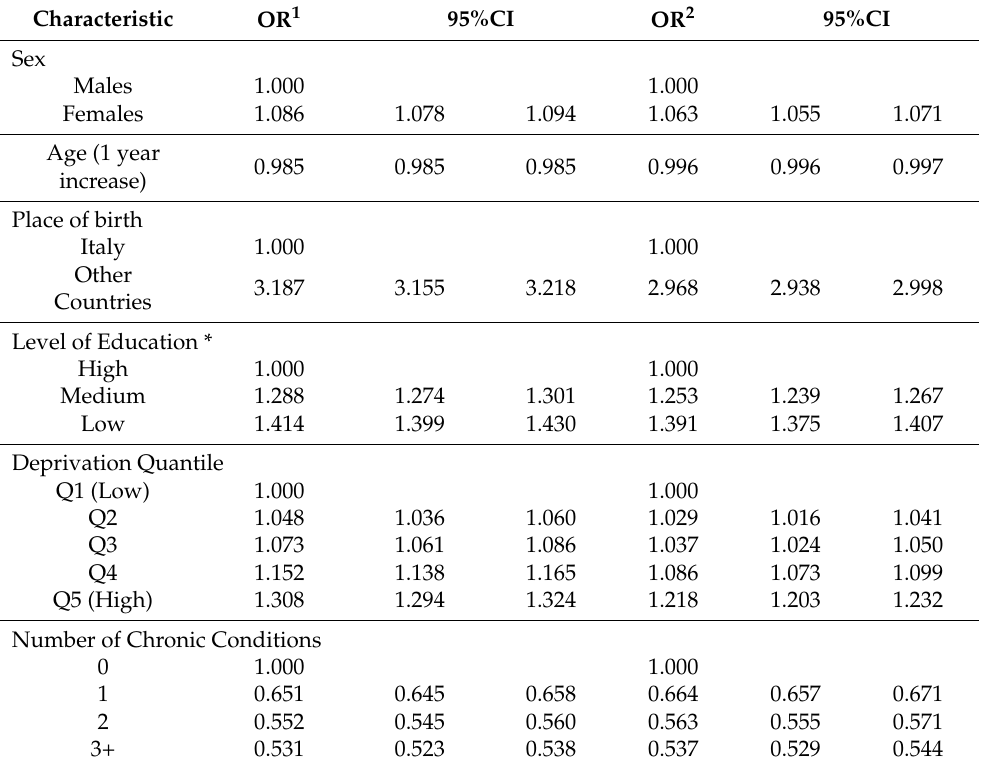
Table 2. Characteristics associated with not getting vaccinated. Lazio Region, population aged 35+ years, 22 December